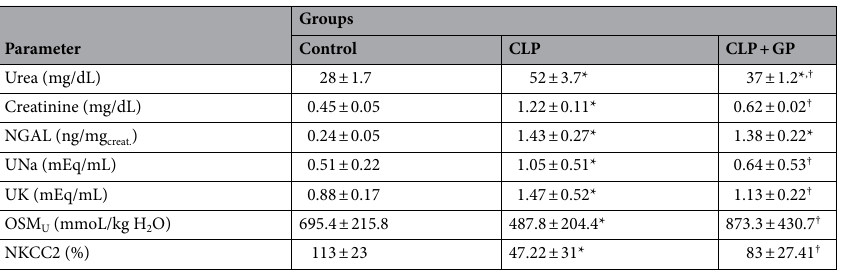
Table 1. Biochemical parameters and Na-K-2Cl cotransporter protein expression. CLP cecal ligation and puncture, GP green propolis, NGAL neutrophil gelatinase-associated lipocalin, UNa urinary excretion